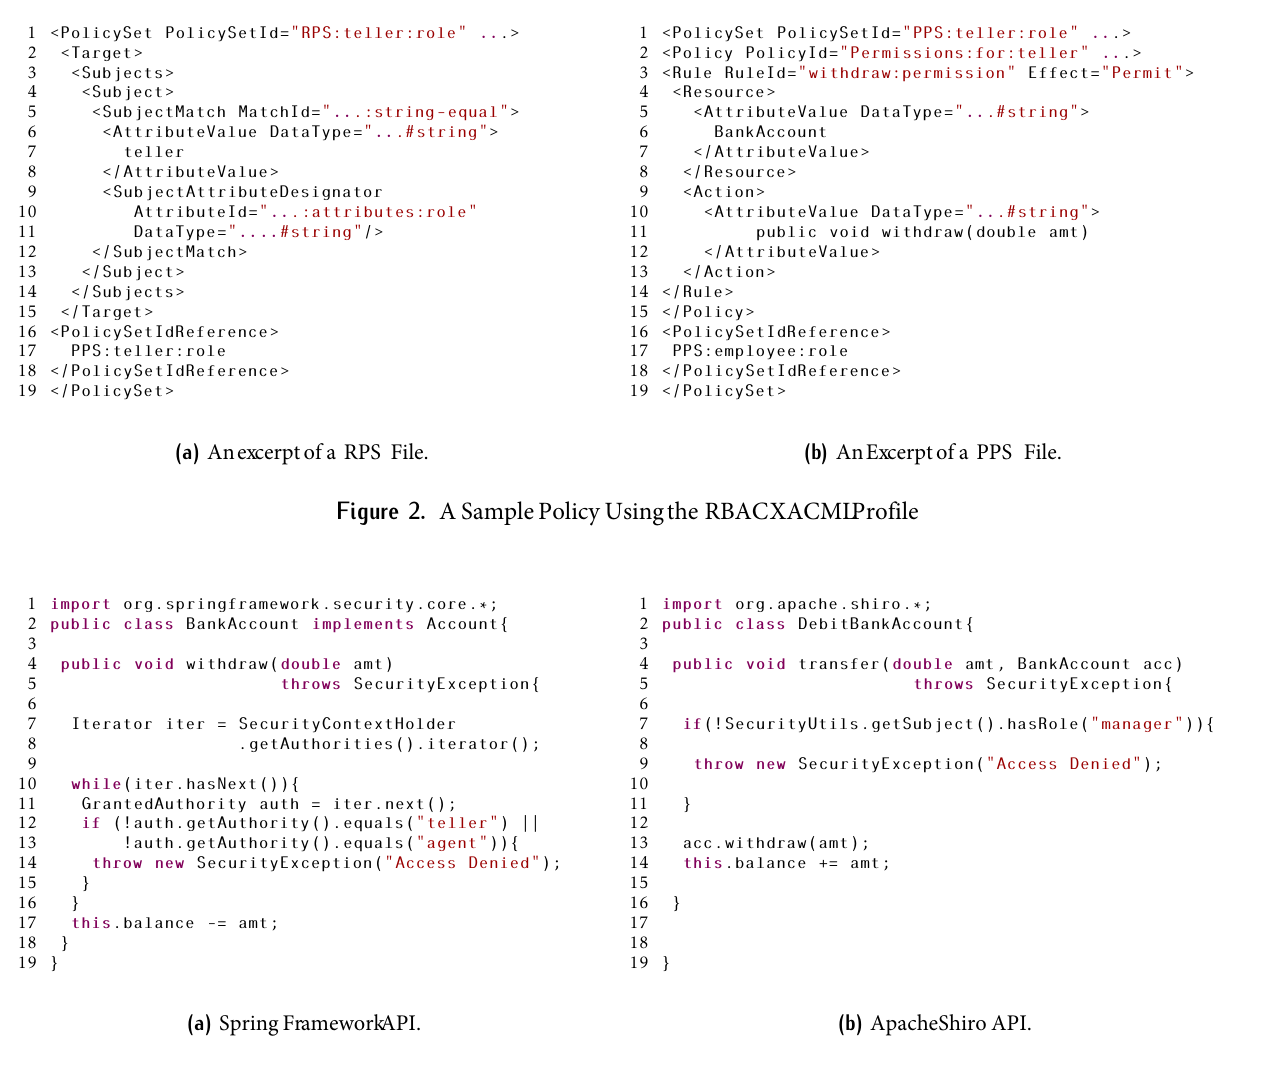
Figure 3. Enforcingan RBACPolicy by Leveraging Heterogeneous Security